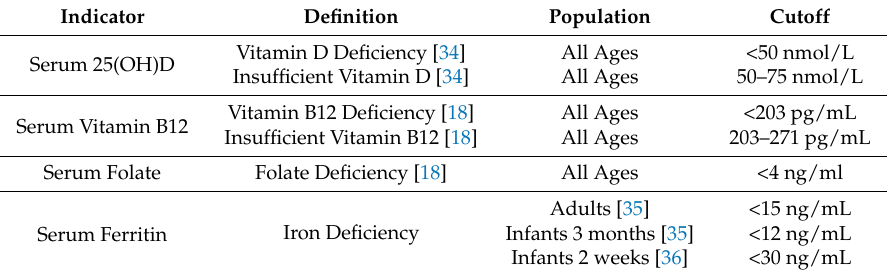
Table 1. Definitions and cutoff values for maternal and infant micronutrient